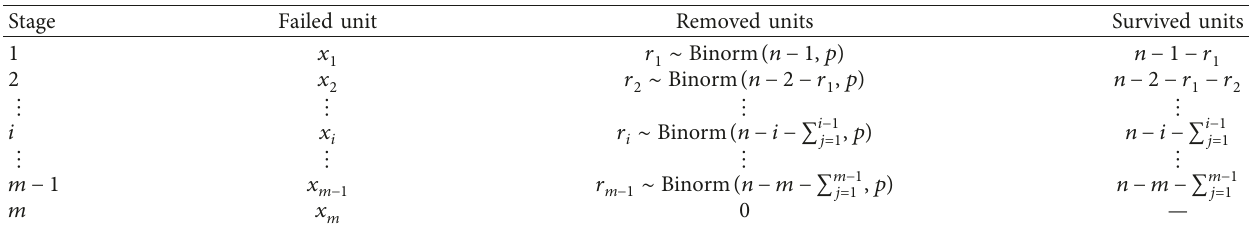
Table 3: Sampling procedure of removals for failure time under progressive type-II censoring scheme when removals follows to the Binomial removals.